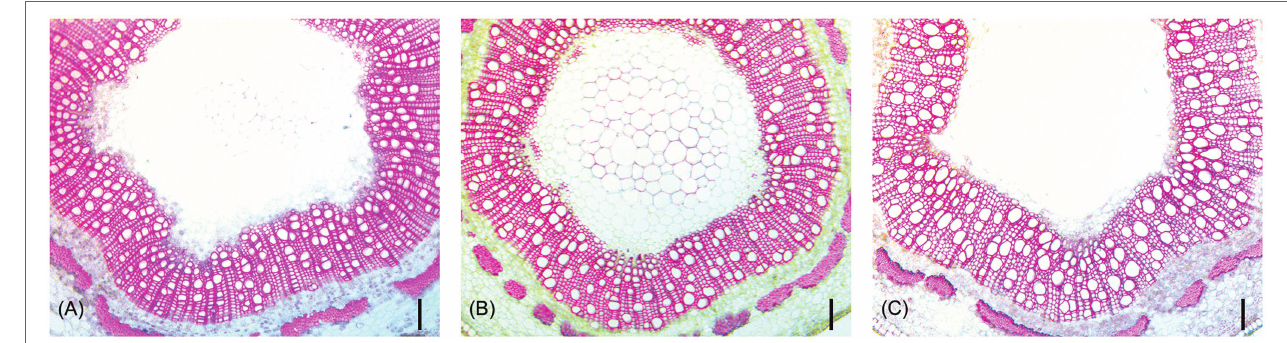
FIGURE 4 | Representative stem cross-sections of three hybrid poplar genotypes that did not differ significantly in tree height (~30 cm), but show significant differences in vessel diameters. Genotype XXX_100_71 (A) had a MVD of 20 μ m, XXX_100_70 (B) had a MVD of 25 μ m, and XXX_100_93 (C) had a MVD of 29 μ m. All scale bars are 100 μ m.